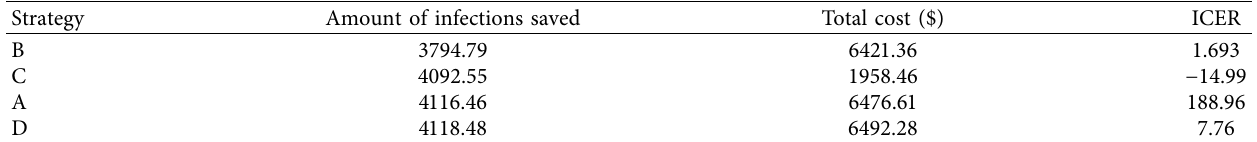
Figure 6: Diagram showing the existence of bifurcation when T � T Table 6: Amount of the total infection averted and total cost used with ICER.